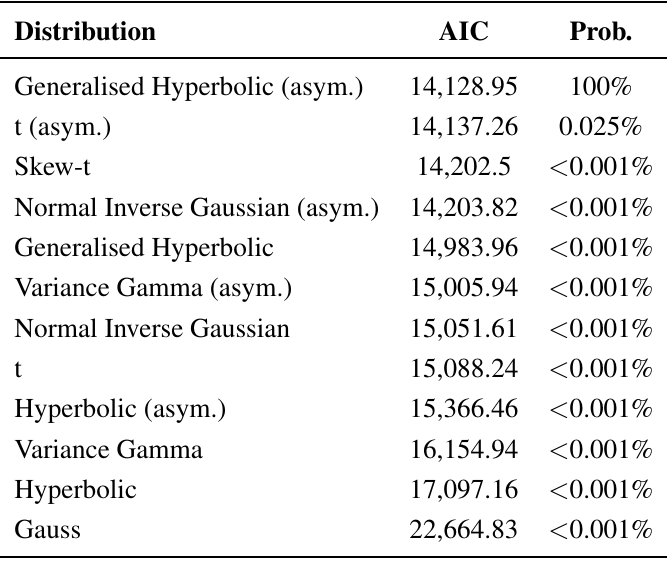
(cid:0) GM (cid:1) Table S1. Normalised metrics ln of known deleterious and neutral variants were C modelled with a selection of continuous distributions. Relative loss of Shannon information incurred when modelling with each distribution is determined by the Akaike Information Criteria (AIC). The final column represents the probability, relative to the best performing model, that the model in question incurs minimal information